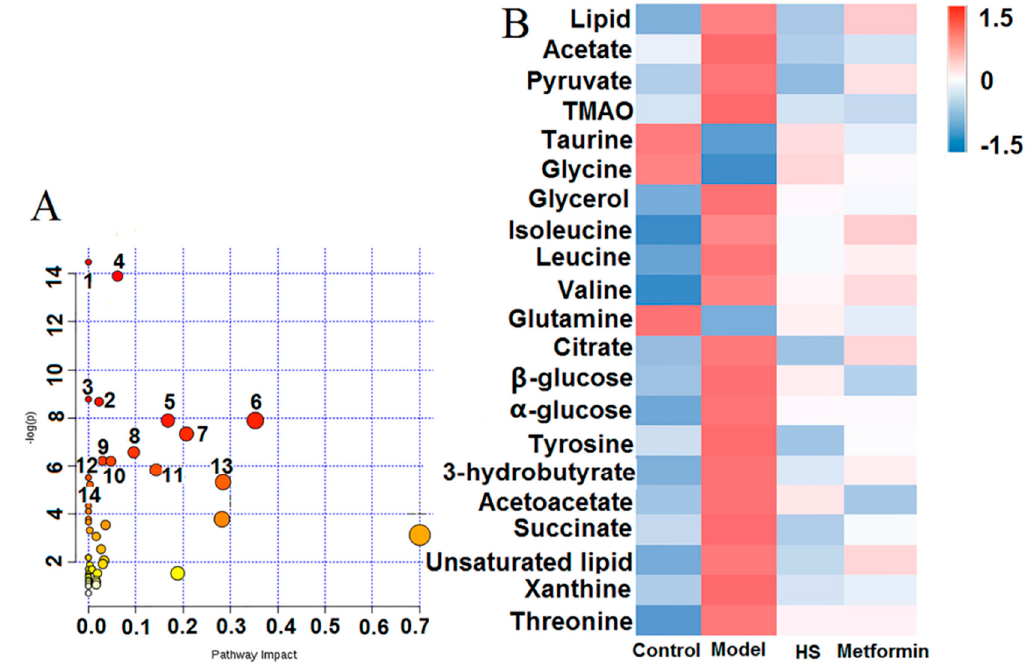
Figure 5. ( A ) Summary of pathway analysis with MetaboAnalyst 3.0. Each dot represents a metabolic pathway, and the label corresponds to the pathway number in Table 2; ( B ) The change of 21 biomarkers in control, model, HS and metformin rats for serum. Table 2. Results of pathway analysis using MetaboAnalyst database.